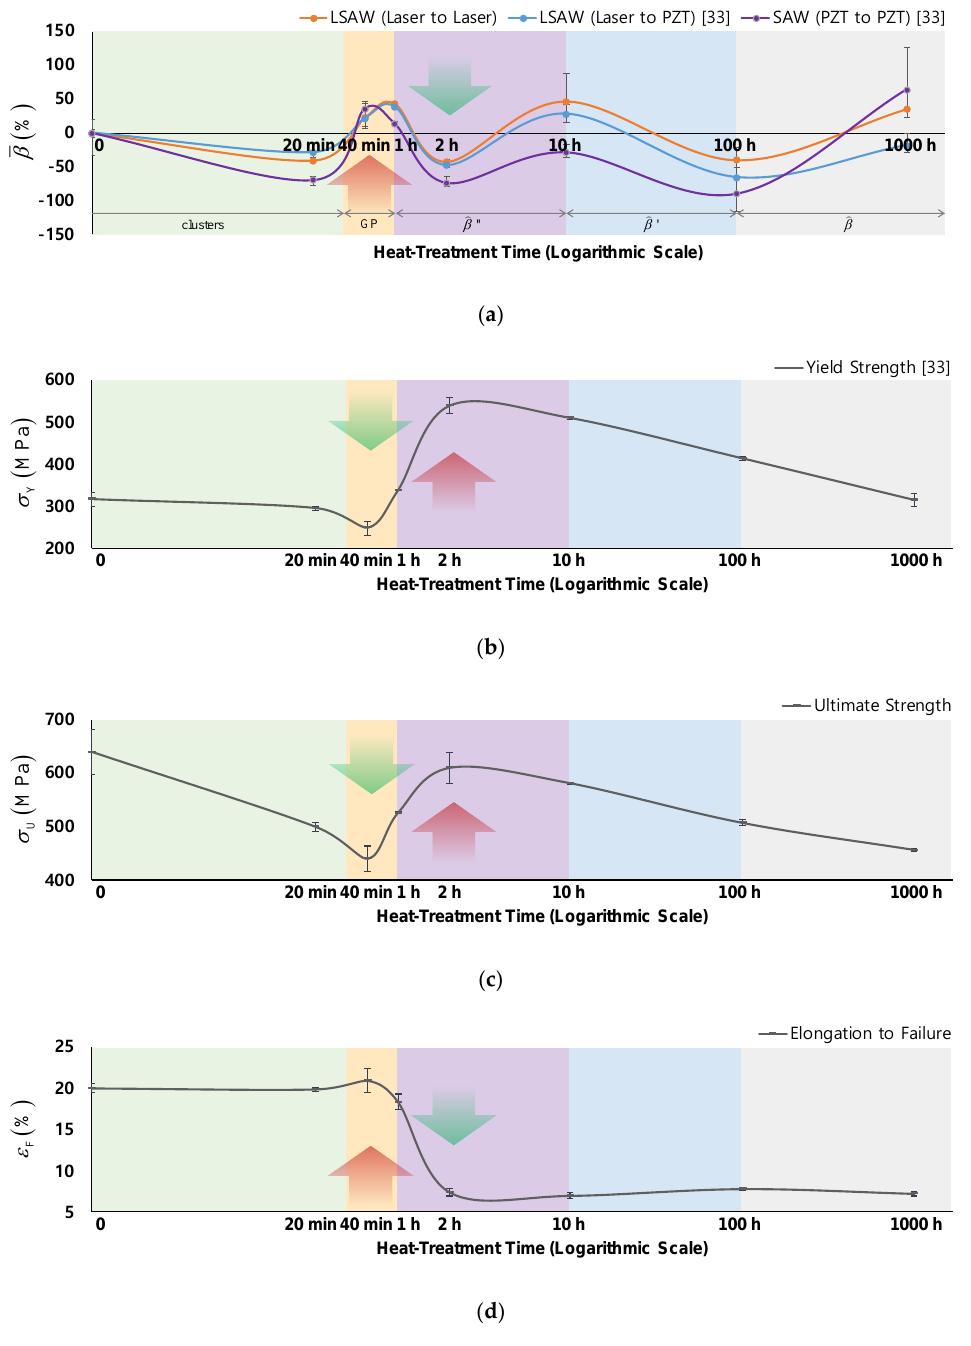
Figure 9. Variation in acoustic nonlinearity and mechanical properties according to thermal aging; ( a ) the fractional change of the relative acoustic nonlinearity parameters between the intact specimen and the thermal-aged specimen; ( b ) yield strength; ( c ) ultimate strength; ( d ) elongation to failure.